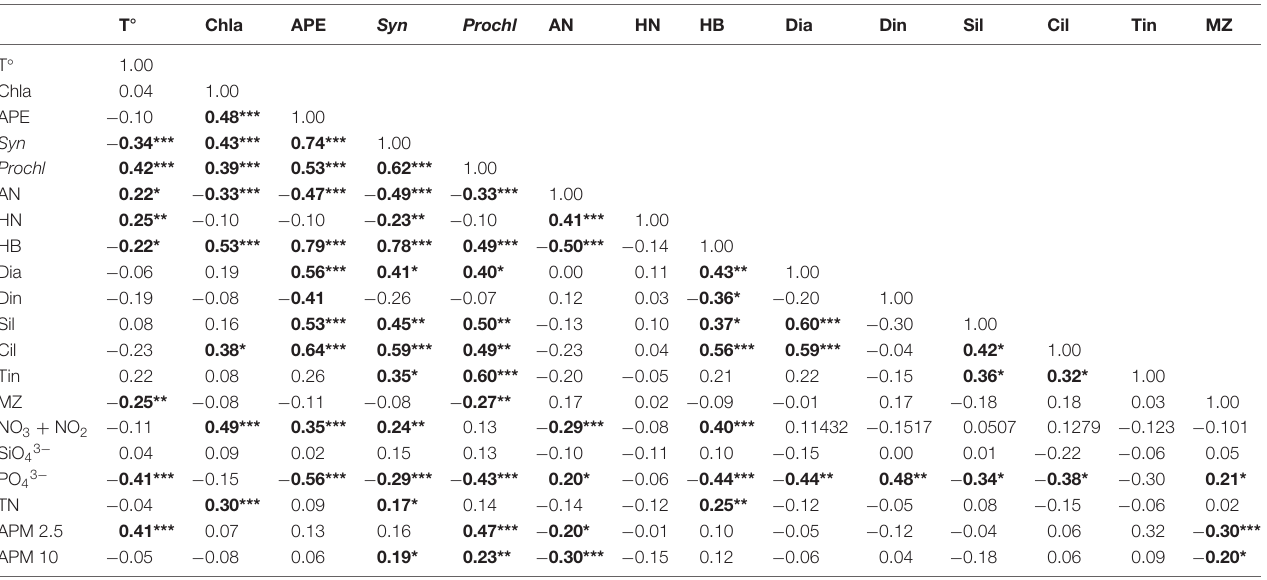
TABLE 2 | Spearman correlation coefficients between biologic variables: temperature (T ◦ ), Chlorophyll a (Chla), autotrophic picoeukaryotes (APE), Synechococcus ( Syn ), Prochlorococcus ( Prochl ), autotrophic nanoflagellates (AN), heterotrophic nanoflagellates (HN), heterotrophic bacteria (HB), diatoms (Dia), dinoflagellates (Din), silicoflagellates (Sil), ciliates (Cil), tintinnids (Tin), mesozooplankton (MZ); and environmental variables: NO 3 + NO 2 , SiO 43 − , PO 43 − , total nutrients (TN), atmospheric particulated matter 2.5 µ m (APM 2.5), atmospheric particulated matter 10 µ m (APM